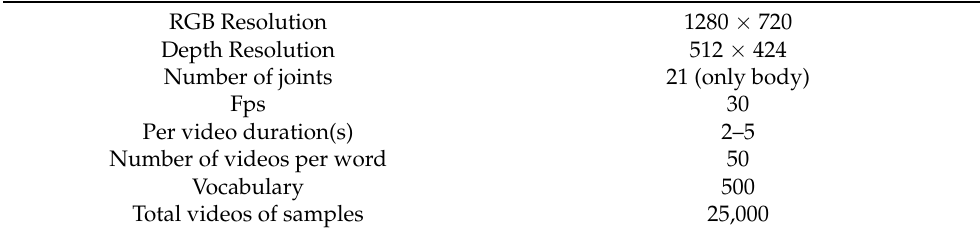
Table 2. Details of the CSL-500